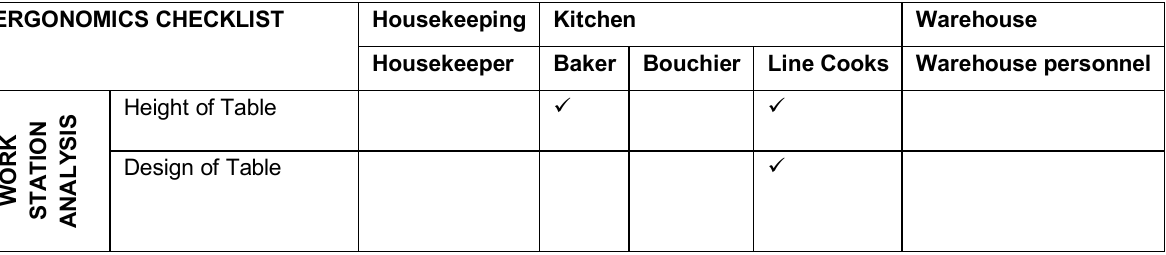
Table 3 : Work Station Analysis